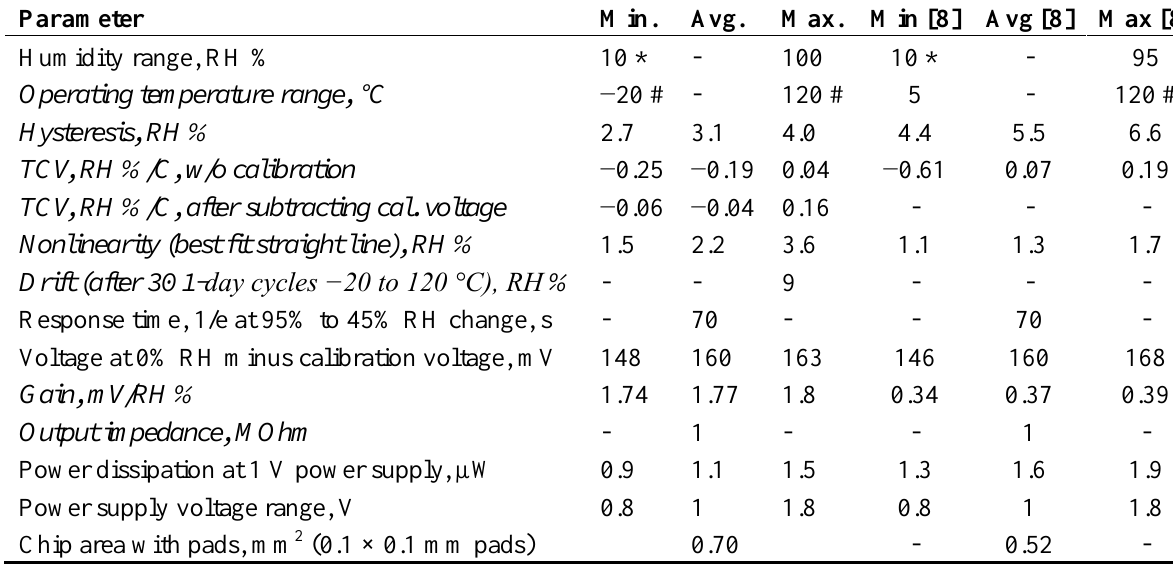
Table 1. Performance summary 2nd batch of five humidity sensors compared with earlier design.